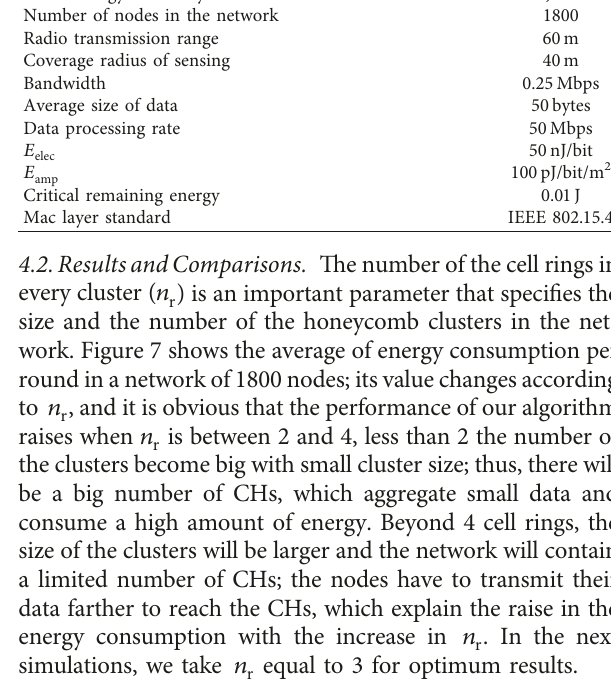
Table 1: Parameters of the simulation. Parameters Values Node distribution